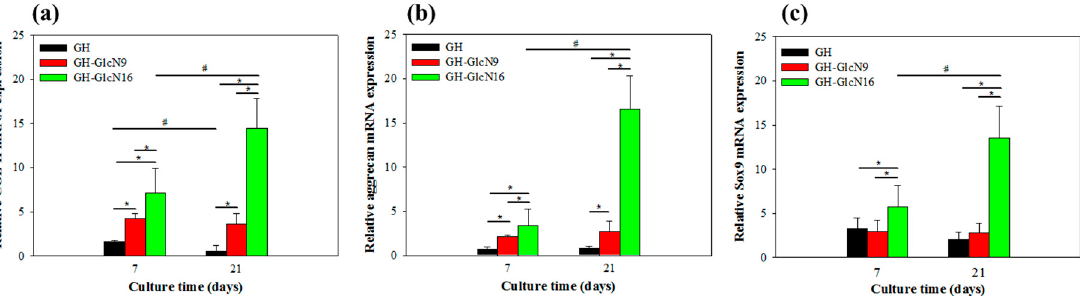
Figure 9. Gene expression of ( a ) type II collagen (COL II), ( b ) aggrecan and ( c ) Sox9 in chondrocytes cultured in GH, GH-GlcN9 and GH-GlcN16 cryogels after 7 and 21 days. * p < 0.05 compared between different cryogels; # p < 0.05 compared between different time points.